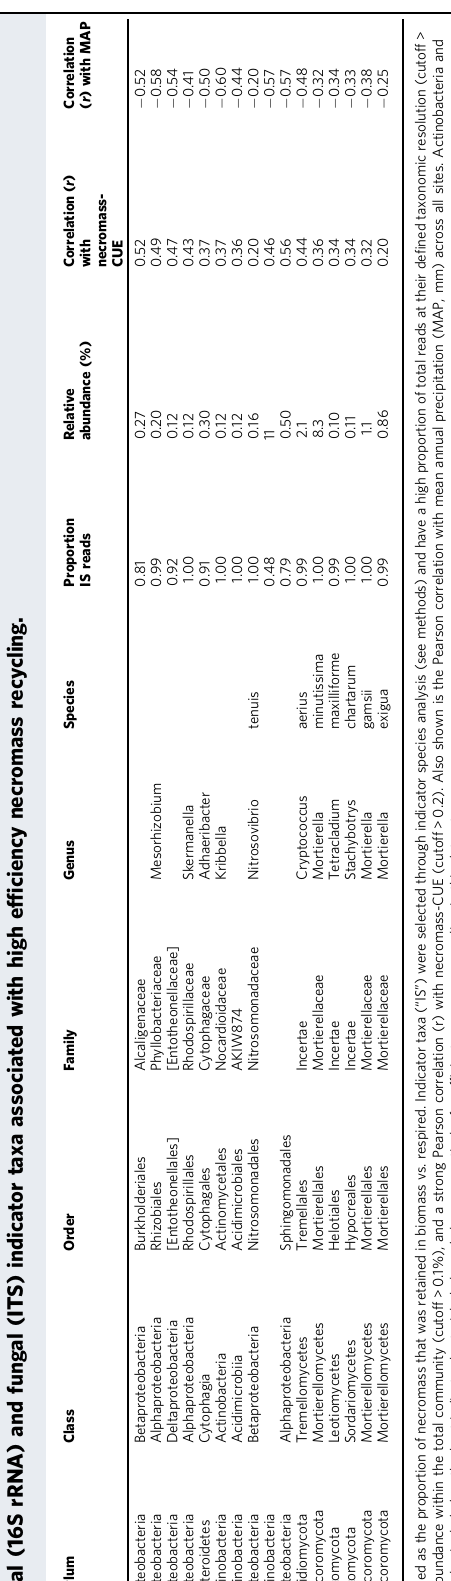
percentage of substrate incorporation into the microbial biomass (%MB 13 C sub ), then multiplied by the microbial biomass pool size ( μ g MBC g − 1 soil) to convert to mass of substrate incorporated into the biomass ( “ MB 13 C ” ). Microbial carbon use ef fi ciency was calculated as: MB 13 C CUE ¼ MB 13 C þ 13 CO 2